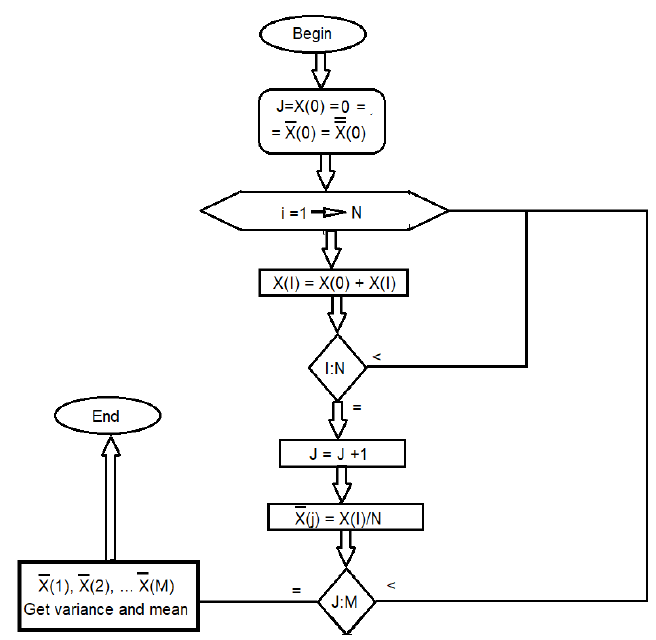
Figure 5. Flow chart of the acquisition of the mean and variance.